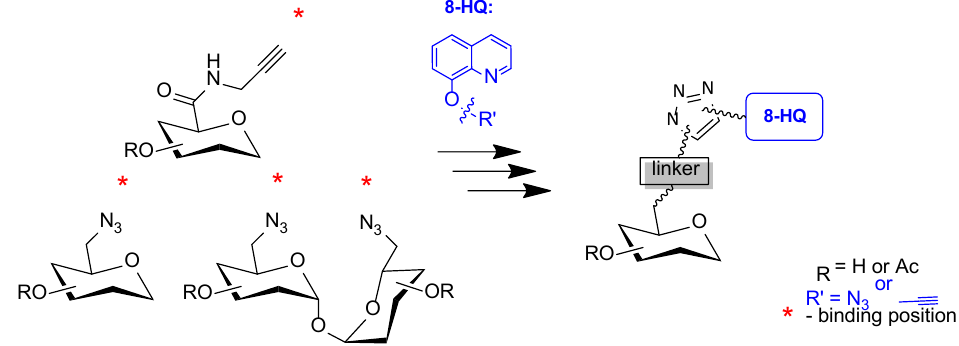
Figure 1. Strategies for the synthesis of quinoline glycoconjugates.